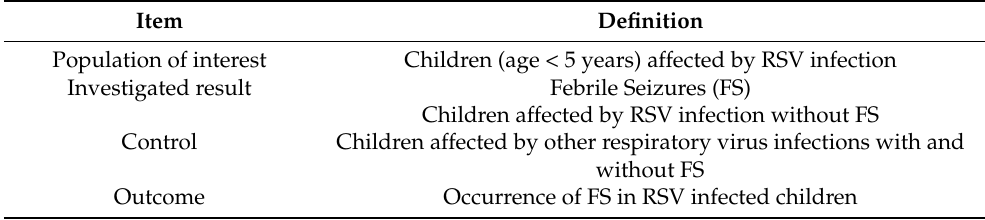
Table 1. PICO worksheet (note: RSV = respiratory syncytial